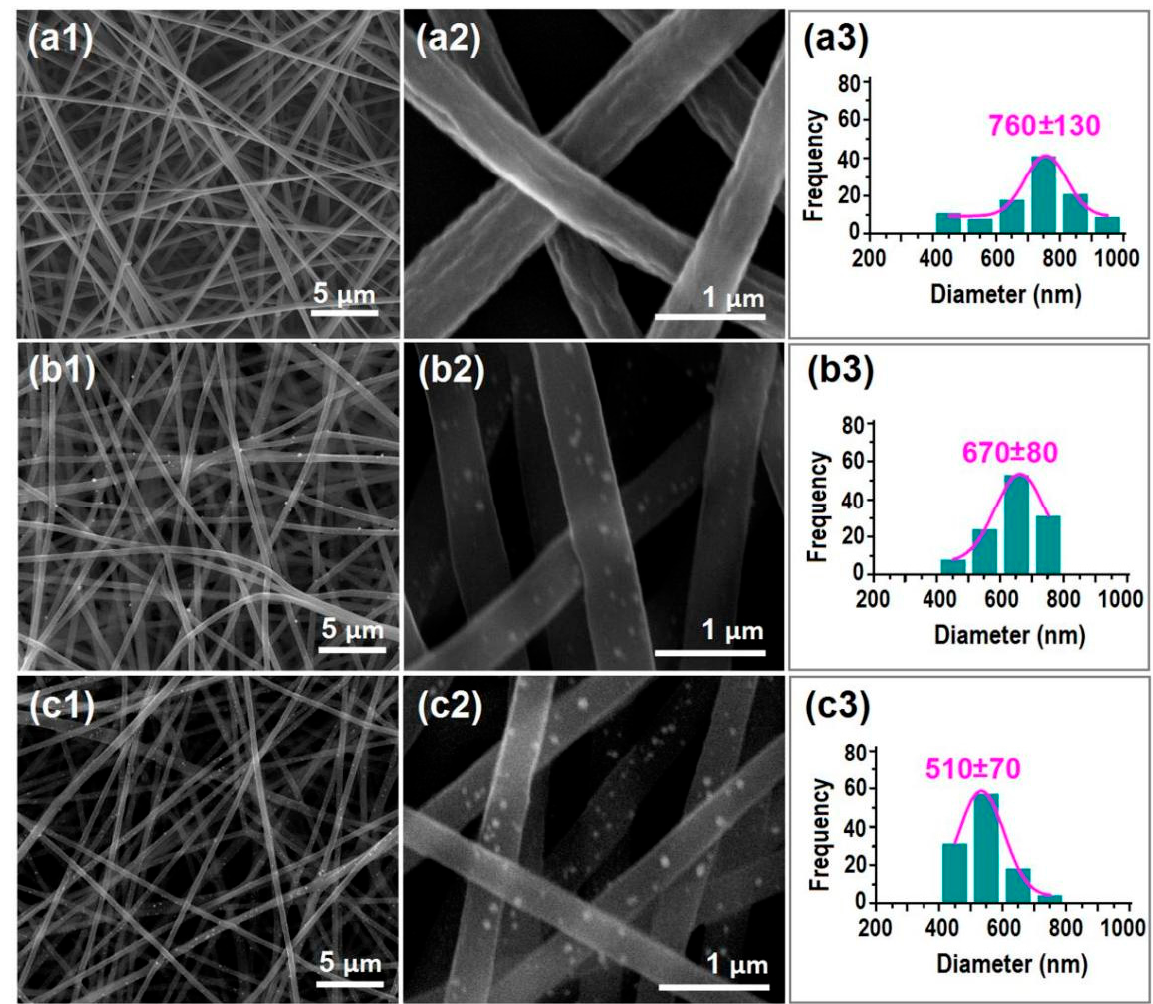
Figure 4. The FESEM assessments of the resultant nanofibers: ( a1 – a3 ) nanofibers of N1, with different magnifications and their size distribution; ( b1 – b3 ) nanofibers of N2, with different magnifications and their size distribution; ( c1 – c3 ) nanofibers of N3, with different magnifications and their size distribution.